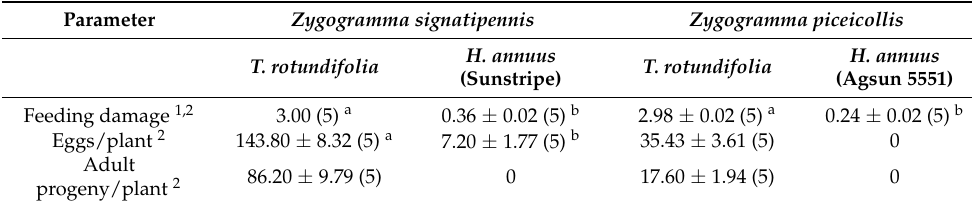
Table 5. Mean ± SE (n) feeding damage, oviposition and production of adult progeny by Zygogramma signatipennis and Z. piceicollis on Tithonia rotundifolia and Helianthus annuus during the paired-choice